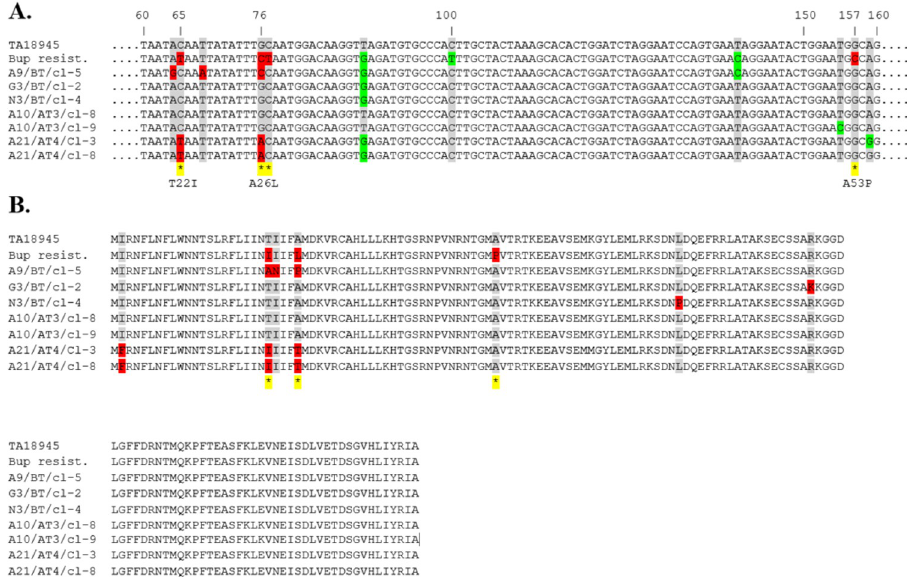
Fig 4. Alignments of TaPIN1 nucleotide (A) and predicted amino acid (B) sequences. Sequences derived from a buparvaquone resistant Tunisian isolate and various Turkish T . annulata isolates with treatment failure history were compared for mutations with the T . annulata / C9 reference genome, obtained from PiroplasmDB.org database; the systematic identifier for TaPIN1 is TA18945. Nonsynonymous substitutions detected among alignments were indicated with an asterisk ( � ) coloured in